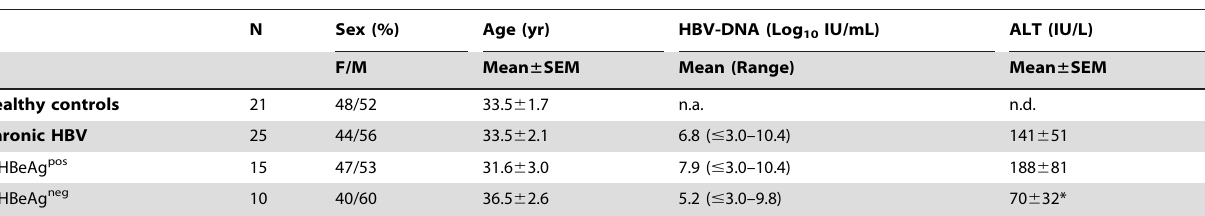
Table 2. Patient